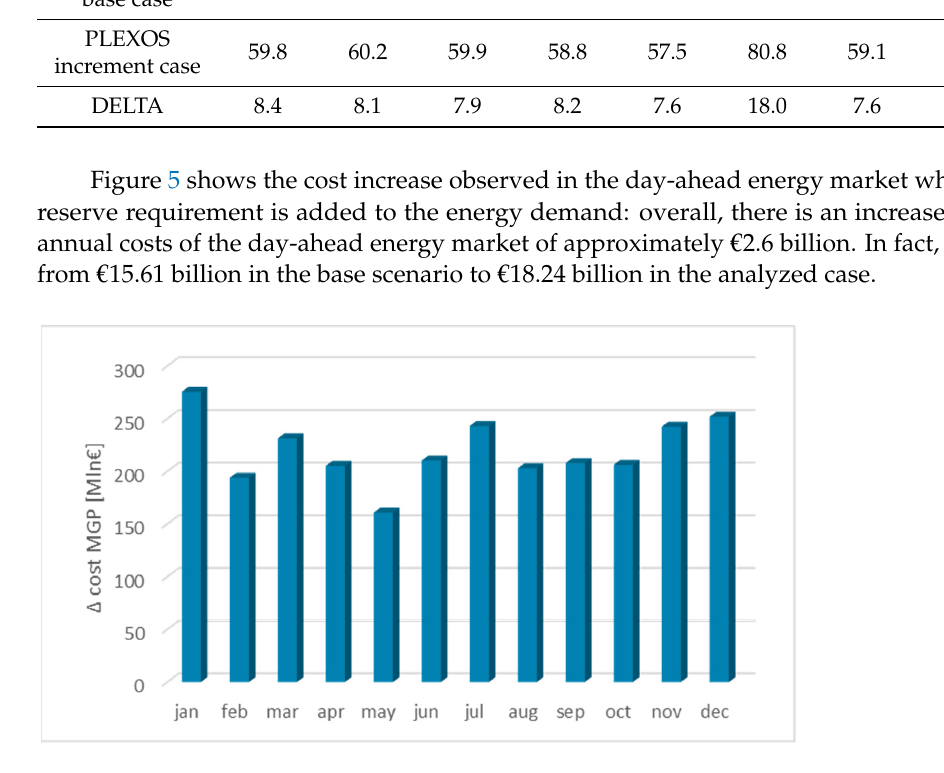
Table 3. Zonal prices and PUN of Plexos base case compared to reserve increment case.